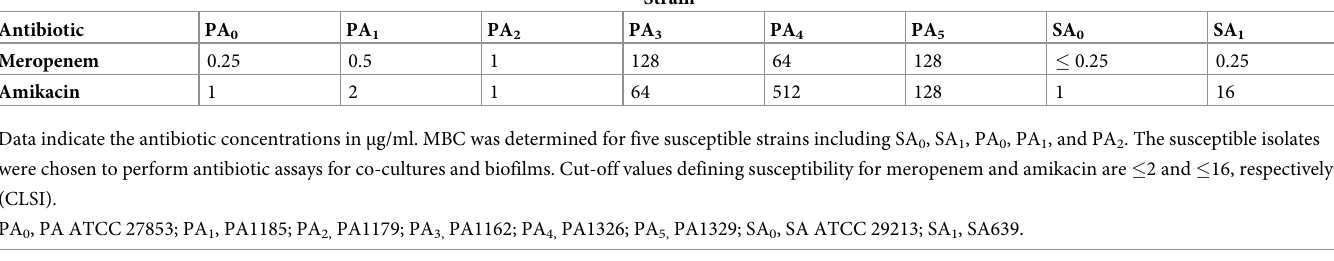
Table 4. MIC results of the antibiotics against planktonic bacterial cells in monoculture.